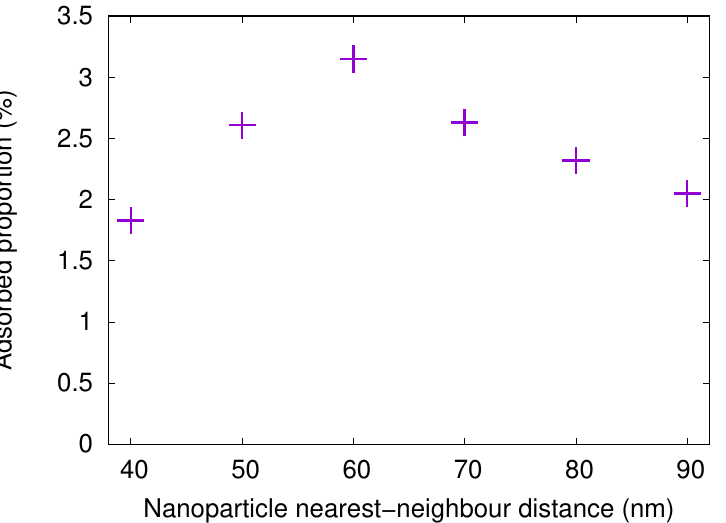
Figure 10. The adsorbed proportion of the fibrinogen α C-chain in simulations with flat surfaces with attached nanoparticles (20 nm radius) with different distances between centers of nearest